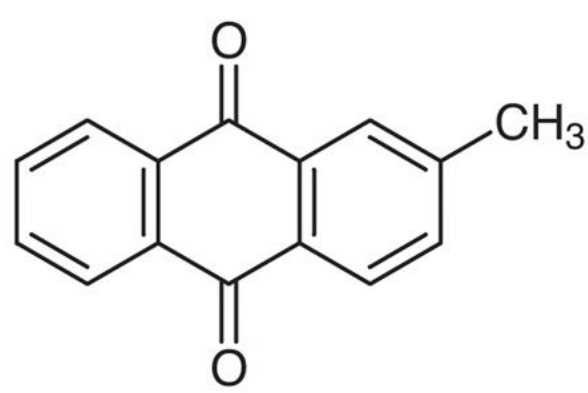
Figure 1 – 2-methylanthraquinone, CAS number 84-54-8, molecular formula C H O , molecular weight 15 10 2